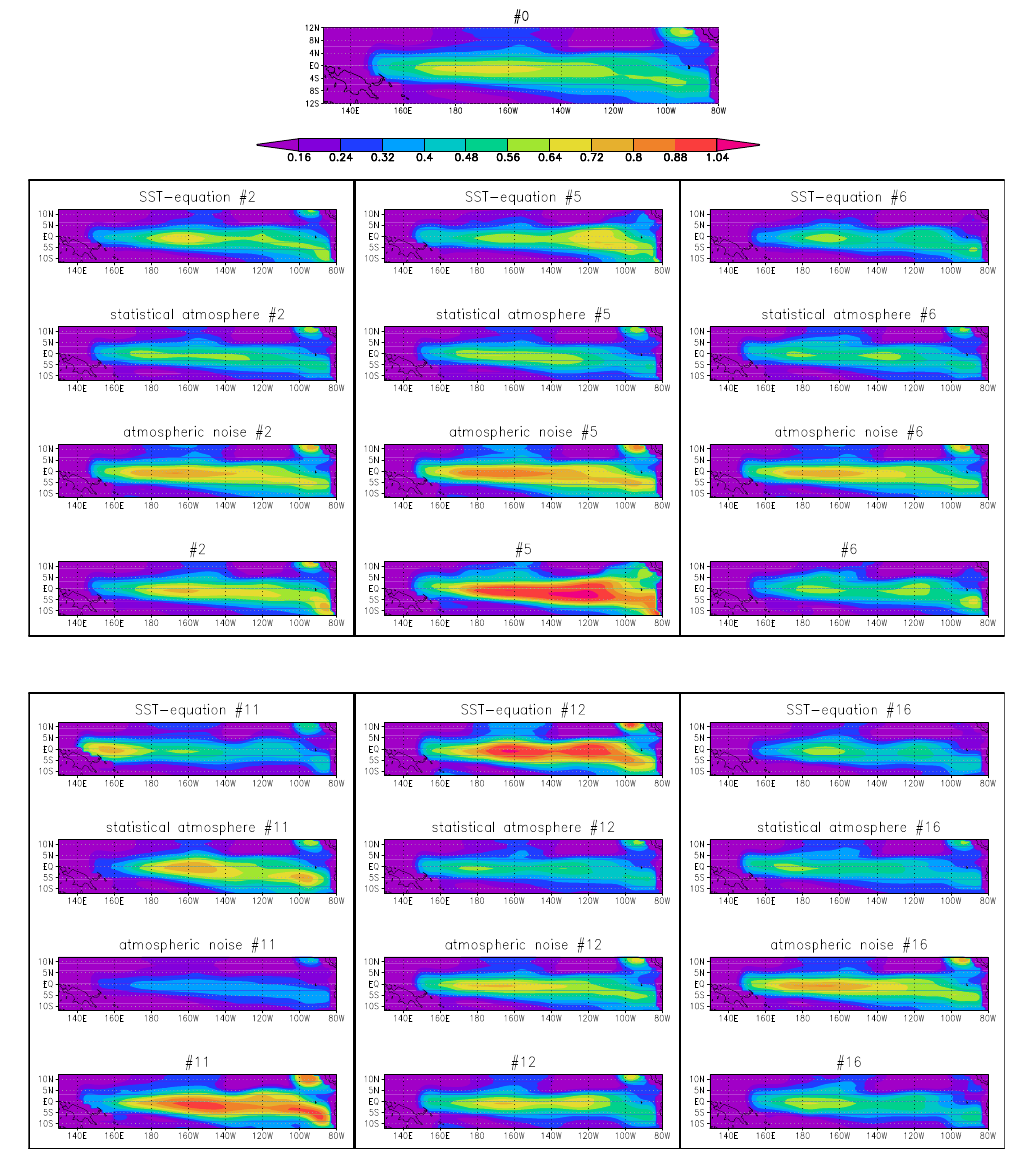
Fig. 10. SST standard deviation σ [K] for a selection of ICM fits to the GCM ensemble members but isolating the influence of different components of the ICM. Top: σ for the STAM member 0 and colorbar. In each of the panels for members 2, 5, 6, 11, 12 and 16, from top to bottom we show σ in an ICM run with only the SST-equation parameters from the perturbed member, but with the other ICM parameters held fixed at the standard values; σ in an ICM run with statistical-atmosphere parameters from that member and all other ICM parameters held fixed at the standard values; σ in an ICM run with atmospheric noise parameters from that member and all other ICM parameters held fixed at the standard values and σ from the full-runs (reproducing the fields in Fig. 9). Note that 11 uses an extra coupling µ = 0 . 82. The influence of the Kelvin wave speed is not shown as it only results in a change in amplitude. See also text.